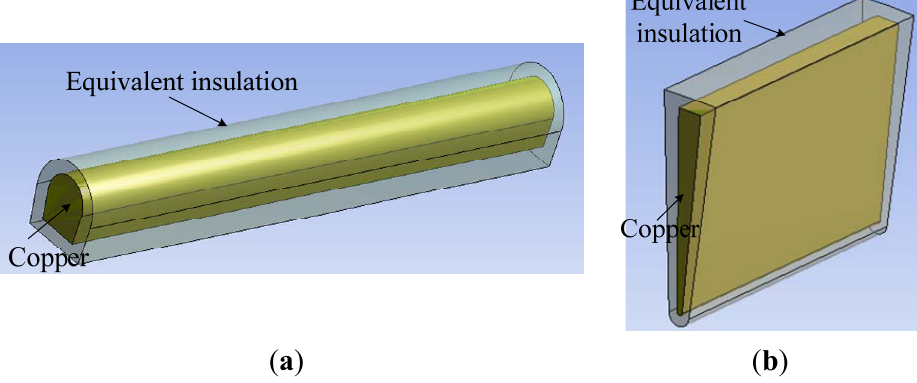
Figure 9. ( a ) Stator winding equivalent model; and ( b ) inner rotor winding equivalent model.